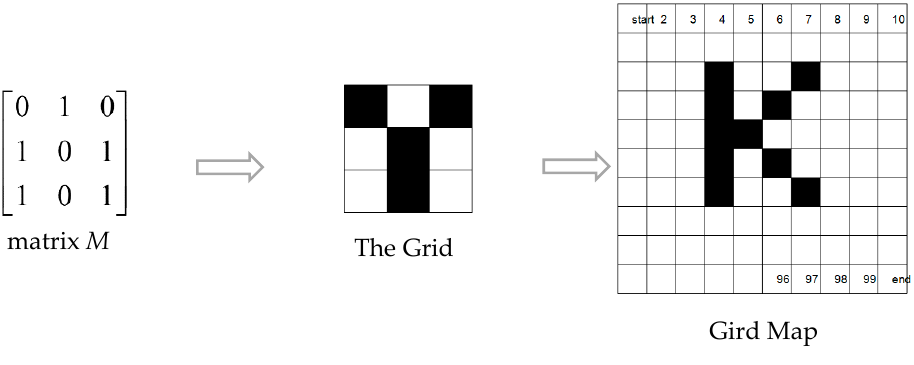
Figure 6. Grid map construction process.